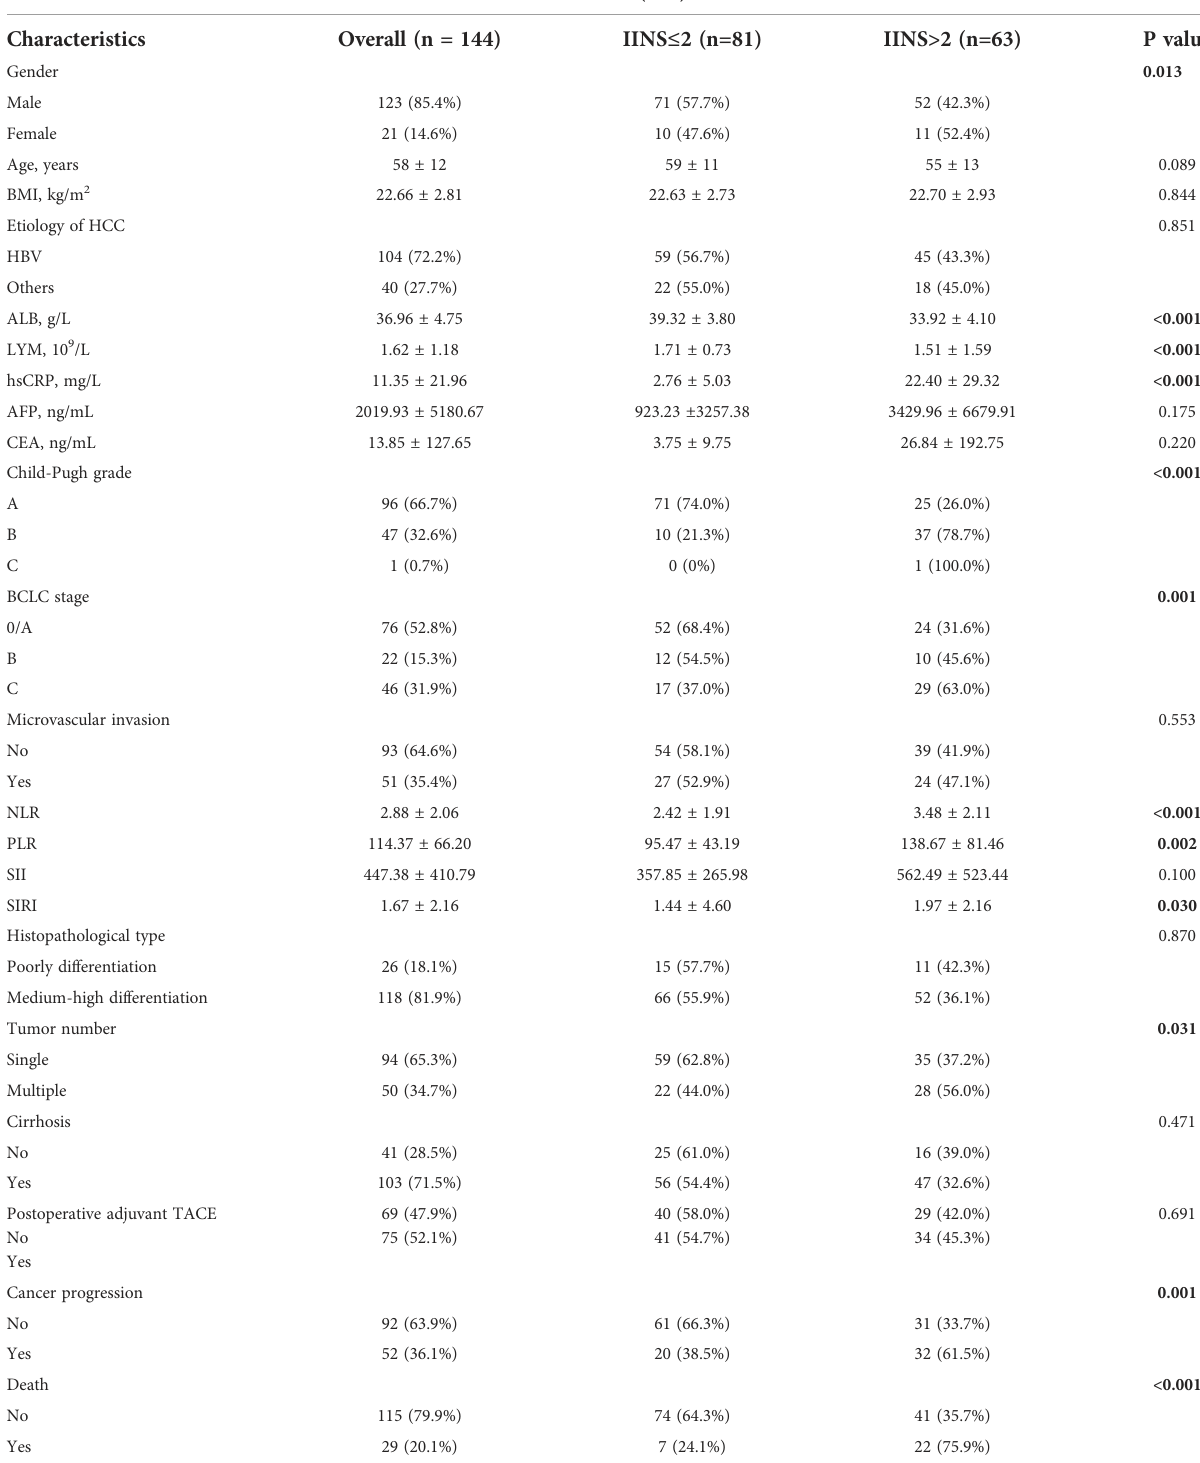
TABLE 1 Associations of the IINS with the clinicopathologic characteristics of HCC patients in the prediction